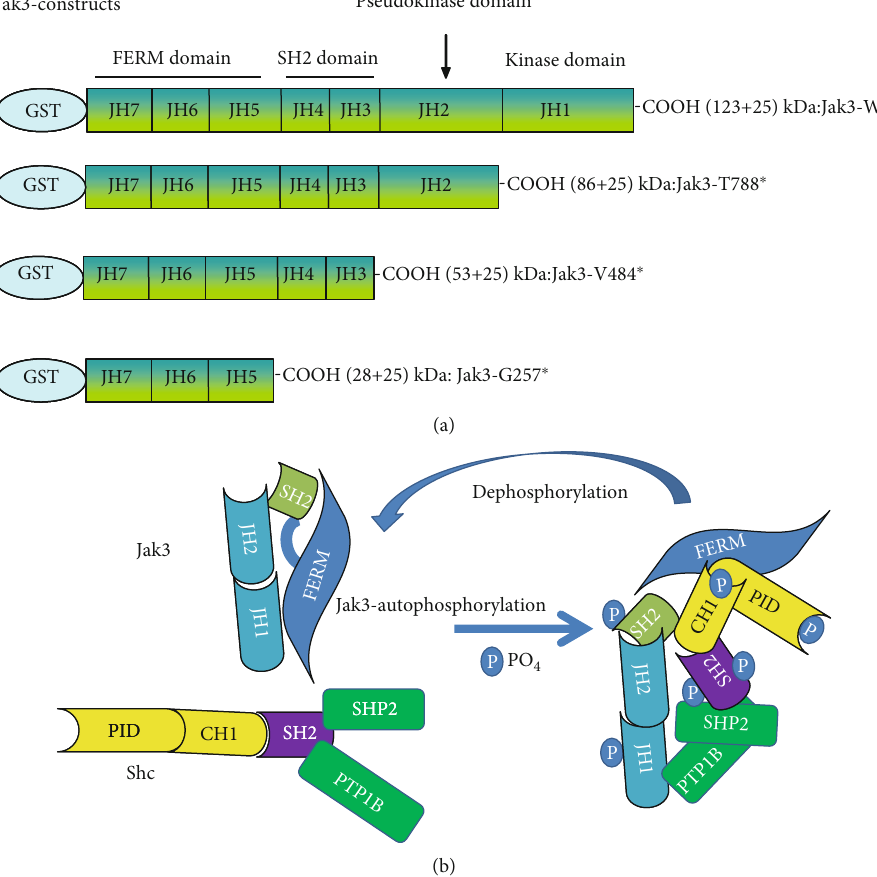
Figure 6: Adapter protein Shc regulates Jak3 activation through regulating Jak3 interactions with tyrosine phosphatases [40]. (a) Schematic representation of GST-Jak3-WT and mutants [39]. (b) Model for Shc-mediated Jak3 dephosphorylation